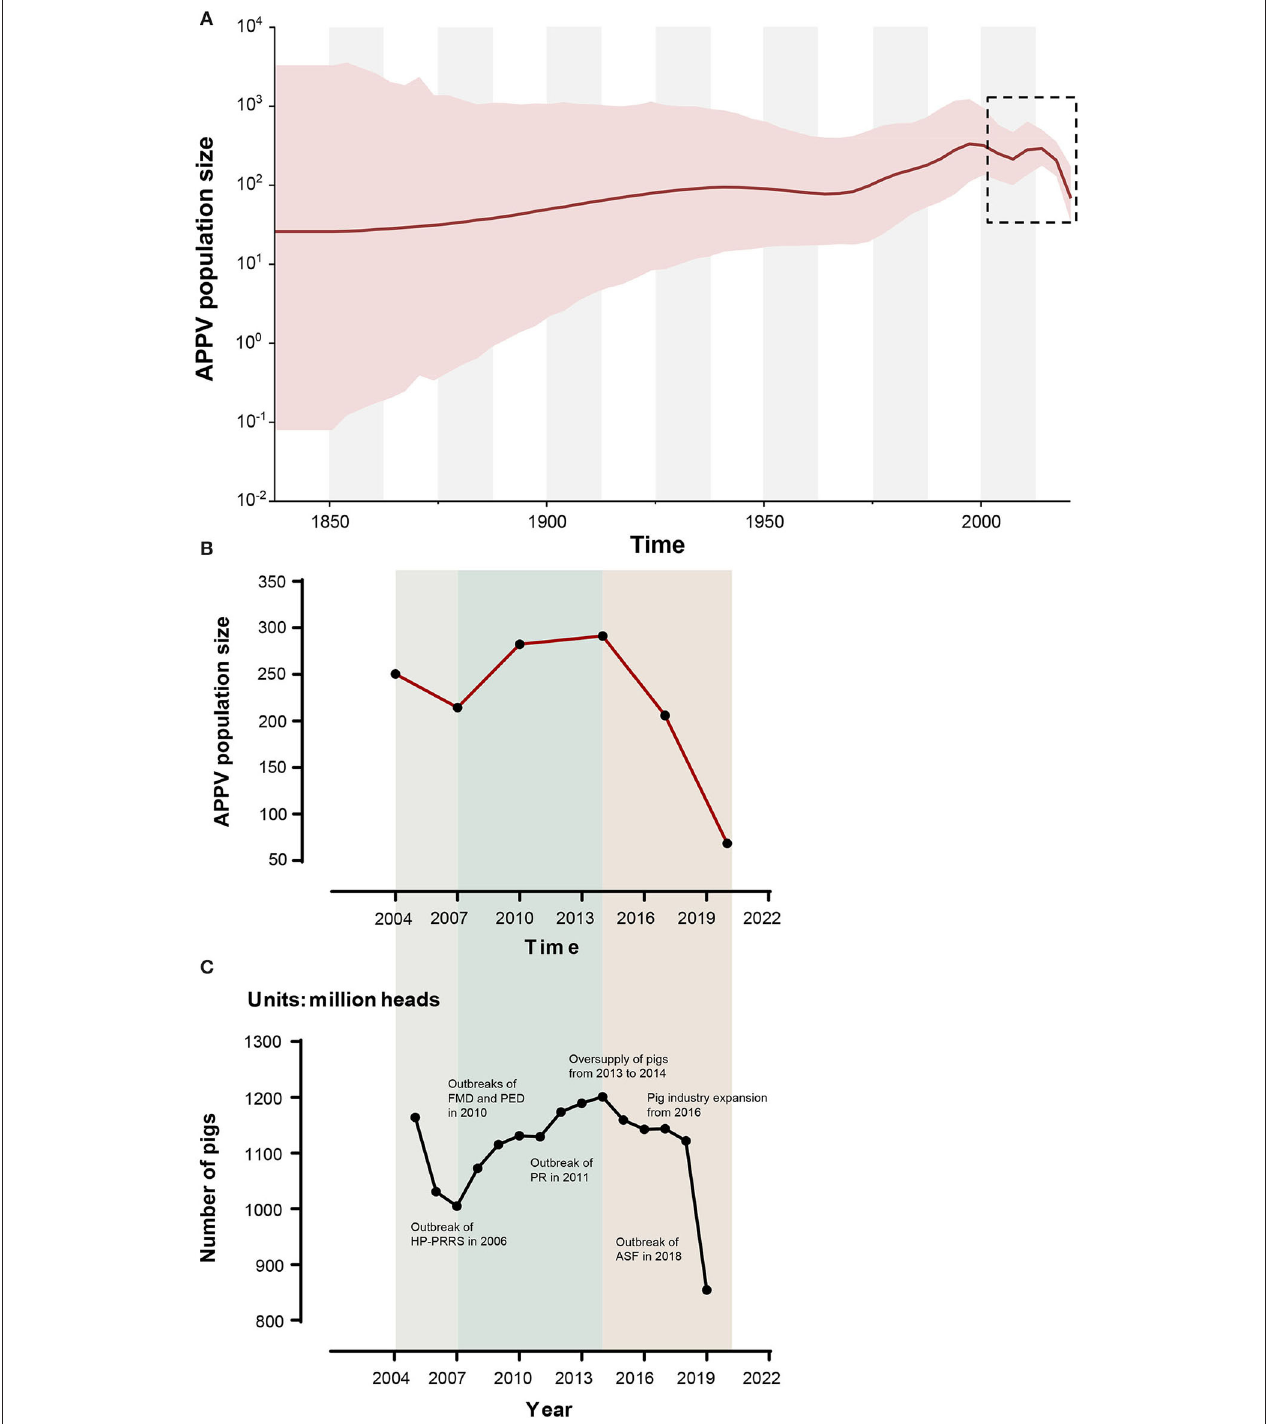
FIGURE 5 | Bayesian skygrid plot of atypical porcine pestivirus (APPV) displaying population size ( y -axis) through time ( x -axis). Solid lines represent the median estimates of population size, and the corresponding shaded areas indicate the 95% highest posterior density confidence intervals (A) . The population size (median) of APPV between 2004 and 2020 is highlighted by black dotted rectangles and is replotted (B) . The dynamic of the number of pigs in China during the past 20 years is shown (C) . These data were obtained from the National Bureau of Statistics (https://data.stats.gov.cn/) and EPSDATA (https://www.epsnet.com.cn/) in China. Multiple events during this dynamic are indicated. HP-PRRS, highly pathogenic-porcine reproductive and respiratory syndrome; FMD, foot-and-mouth disease; PED, porcine epidemic diarrhea; PR, porcine pseudorabies; ASF, African swine fever.